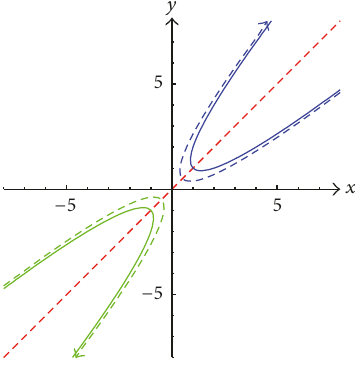
Figure 15: The asymptotic behavior of {𝑃 𝑘 } plotted by Tracking Procedure with 𝜌 = −2